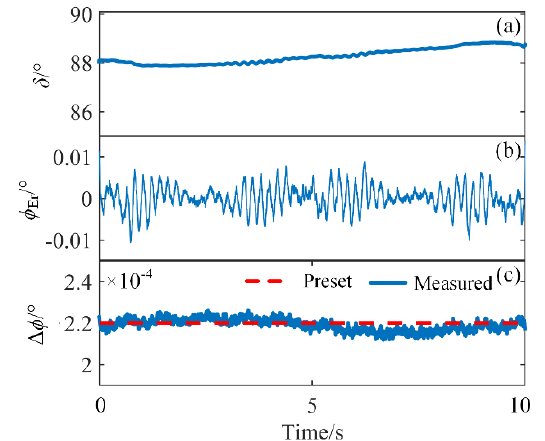
Figure 7 Relative results in the normal incidence experiment: (a) retardance δ over time; (b) measurement error ϕ Er over time, in which ϕ Er is defined as the preset results minus the measured results. (c) the measured and preset resolution Δ ϕ over time, in which Δ ϕ ( t ) = ϕ ( t +Δ t ) - ϕ ( t ), Δ t =11 μs;